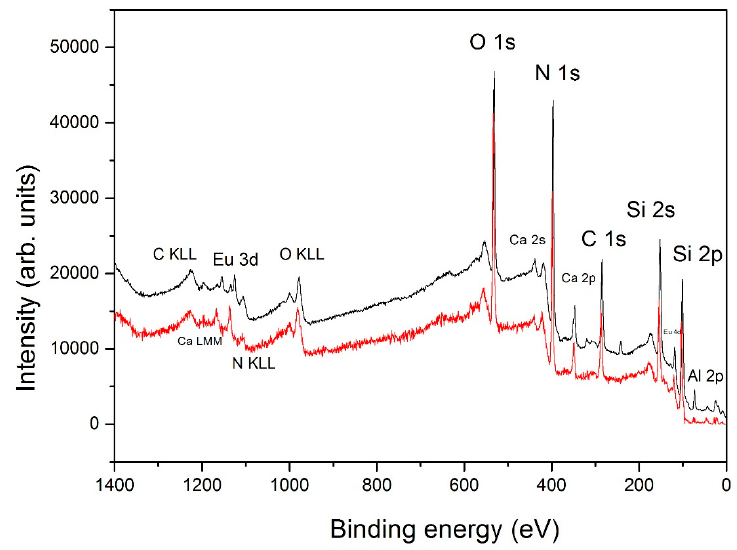
Figure 2. XPS survey spectrum of Eu-4 mol%-sialon of the as-received powder (bottom line) and after 1 minute Ar ions etching (upper line).